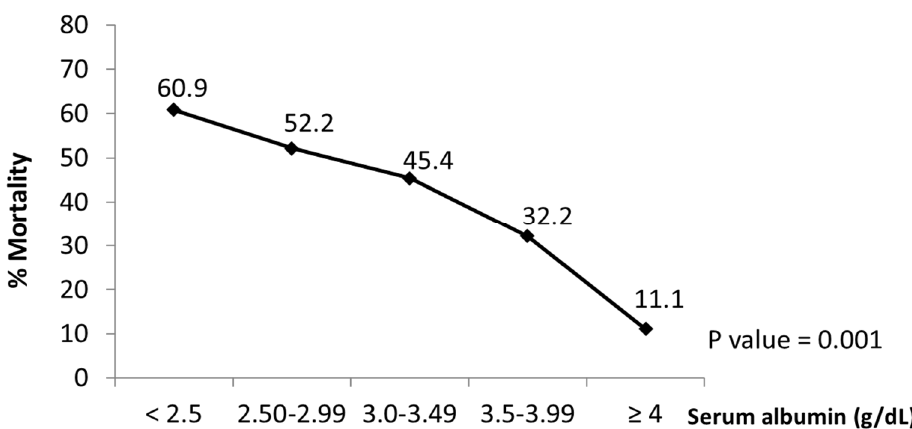
Figure 2. Association between serum albumin and mortality in COVID-19 patients. The graph shows the decreased rates (%) of in-hospital mortality at 30 days from all causes associated with on admission increased serum albumin levels in COVID-19 patients. Data obtained from the multi-center cohort-study on impact of admission serum albumin levels for the prediction of <30 days in-hospital all-cause mortality in COVID-19 patients, Spain, August-November 2020 (n = 1555). Interestingly, patients with low albumin levels (<3.5 g/dL) and low glucose levels (<100 mg/dL) showed a lower mortality rate than patients with low albumin levels (<3.5 g/dL) but with glucose levels above 100 mg/dL (Figure 3). This observation was more ev- ident when on-admission albumin levels were below 2.5 g/dL (Figure 3). Gender did not